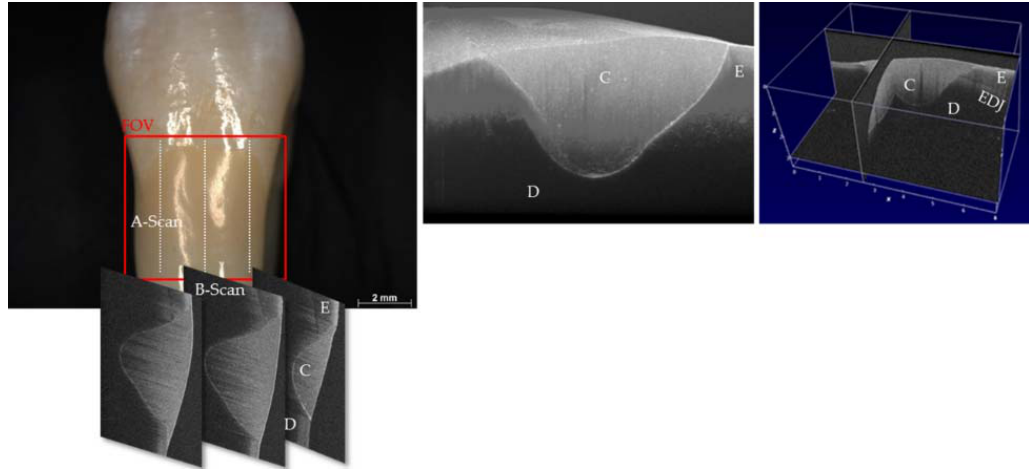
Figure 3. SD ‐ OCT imaging (2D, 3D) of an extracted human premolar restored with composite (C). FOV: field of view, E: enamel, D: dentin, EDJ: enamel ‐ dentin